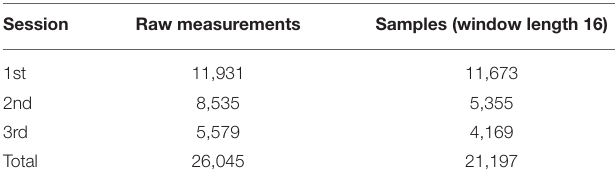
TABLE 3 | Measurement (sensor readings) and sample (overlapping time windows of length 16) counts in the MicroBeTa dataset and relevant subsets thereof. Session Raw